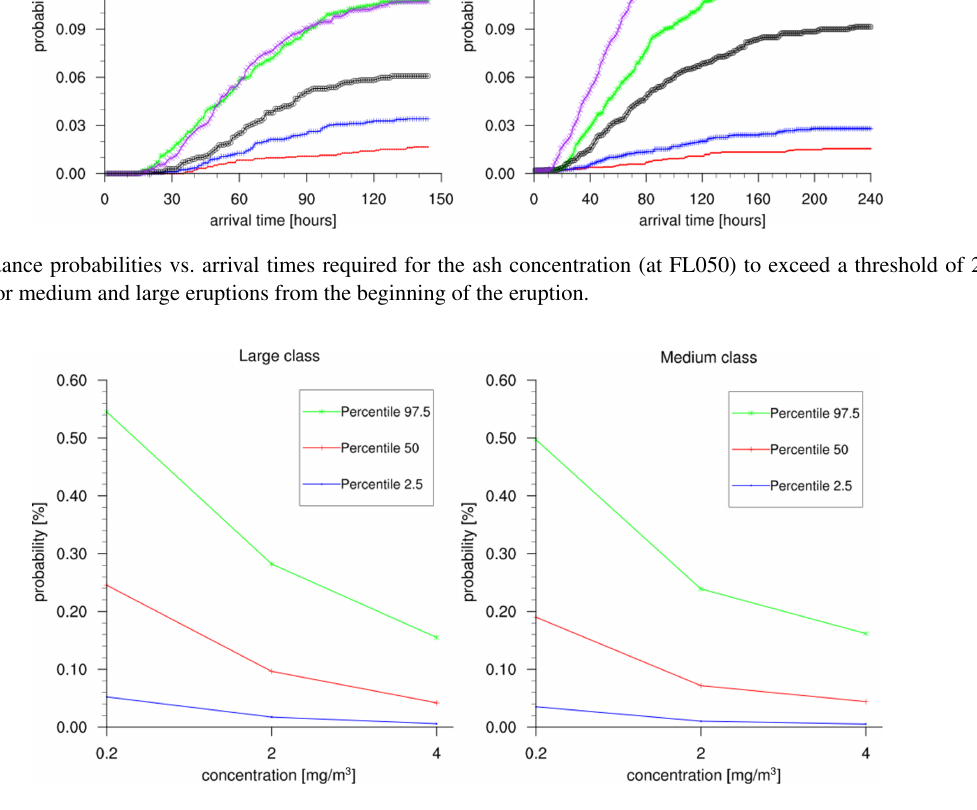
Figure 14. Concentration analysis: relative uncertainties related to airborne ash cloud concentrations above 0.2, 2, and 4mgm − 3 at FL050 at Keflavik